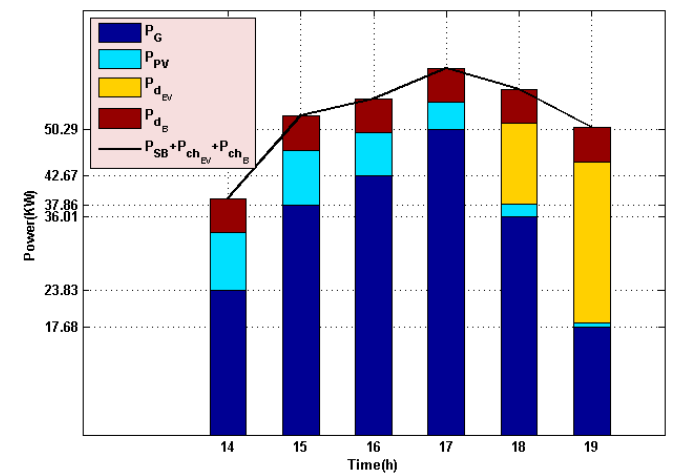
Figure 6. Specification of each type of source that feeds the building and the EVs charging process in scenario 3.